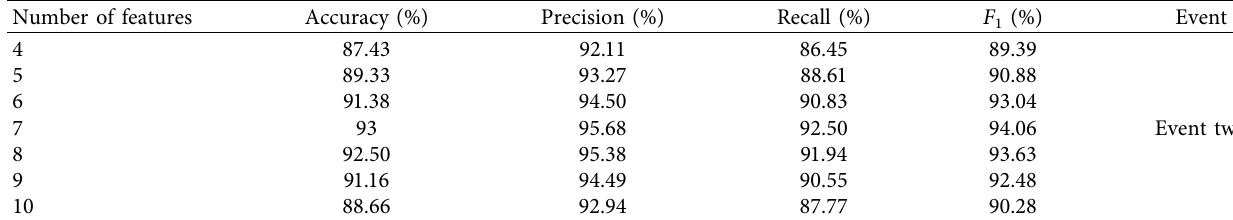
Table 8: Model performance with different indicators in event two.